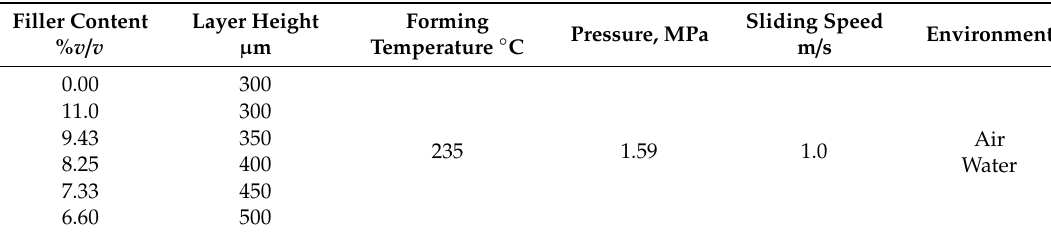
Table 5. Experiment parameters